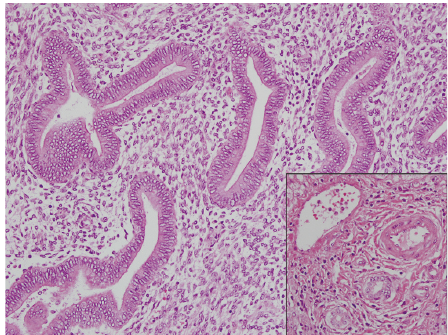
Figure 4: High-power view of an endometriotic nodule. Endometrioid type glands of varying shape and size show characteristic columnar lining, within a cellular endometrial type stroma. The inset shows a portal tract for comparison (from top to bottom: vein, artery, bile ducts); notice the small round shape of the bile ducts and lack of cellular stroma. Hematoxylin & Eosin,